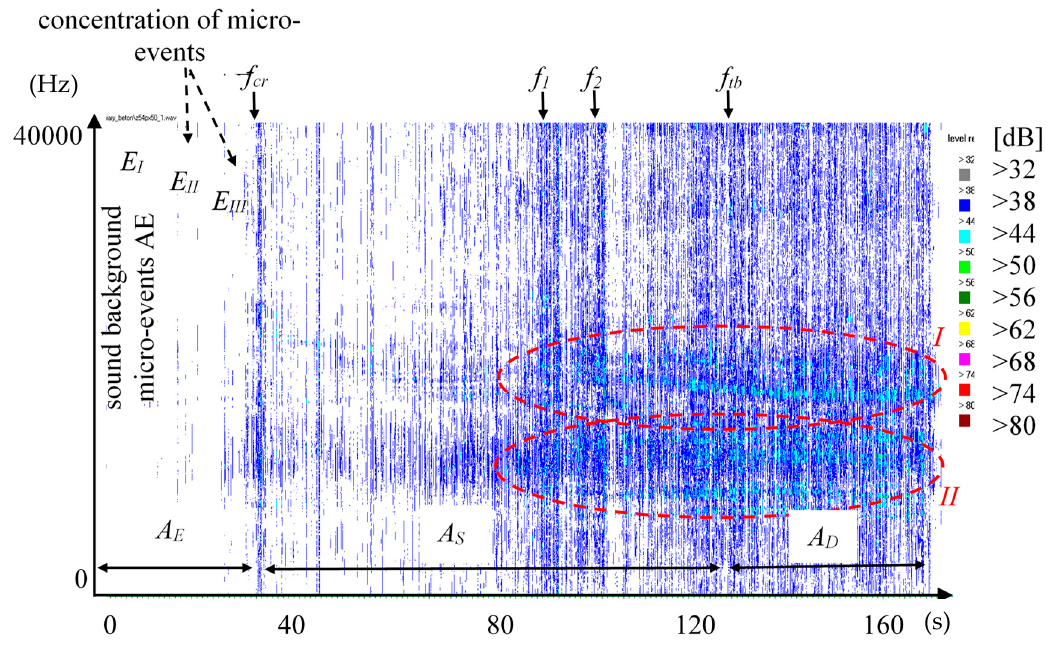
Figure 5. Spectogram of the AE signal.